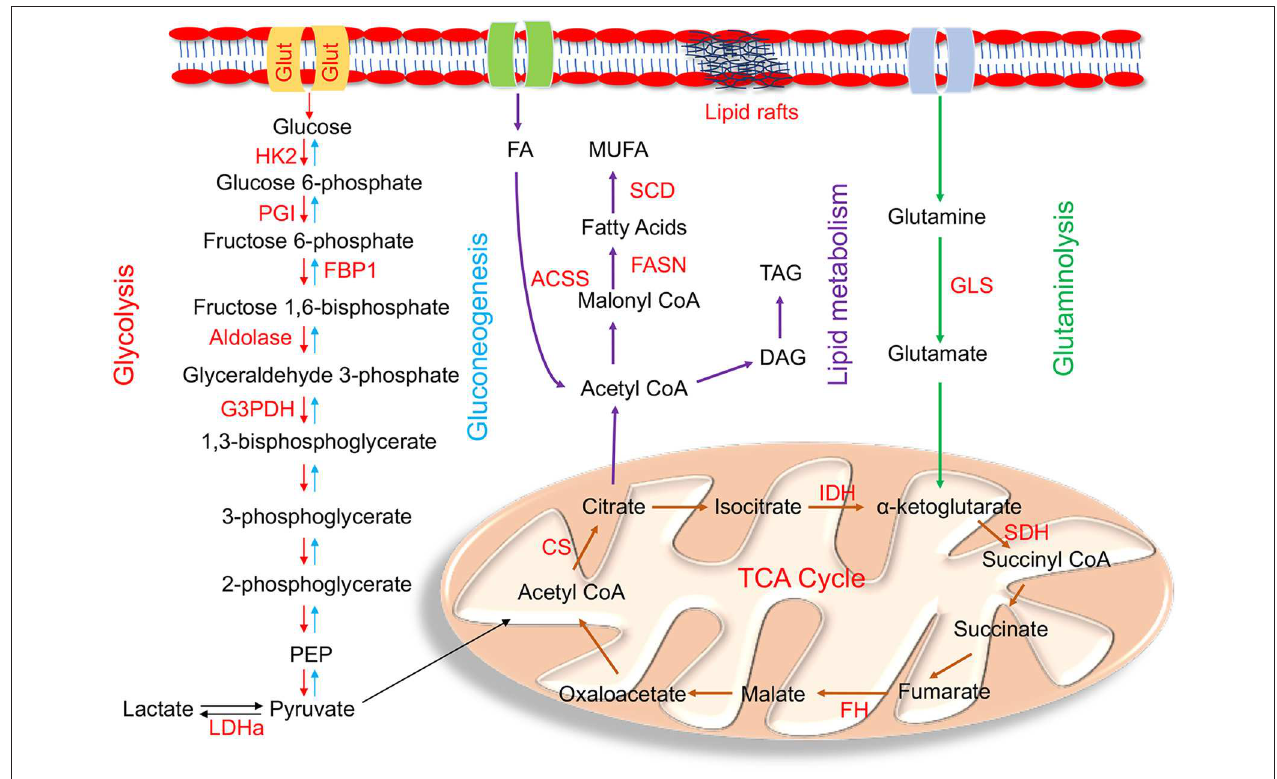
FIGURE 1 | Enzymes within their pathways that are implicated in metabolic reprogramming during EMT. Schematic diagram of enzymes (highlighted in red) within the metabolic pathways of glycolysis, gluconeogenesis, mitochondrial, glutamine, and lipid metabolism alluded in the text that are altered during metabolic reprogramming that occurs in EMT. The main glycolytic enzymes that are upregulated in EMT are HK2 (hexokinase 2); PGI (phosphoglucoisomerase); aldolase, G3PDH (glyceraldehyde-3-phosphate dehydrogenase), and LDHa (lactate dehydrogenase a). FBP1 (fructose-1,6-bisphosphatase), the rate limiting enzyme of gluconeogenesis, is downregulated during EMT. Mutations in the tri-carboxylic acid (TCA) cycle enzymes linked to EMT are IDH (isocitrate dehydrogenase); SDH (succinate dehydrogenase); FH (fumarate hydratase); and CS (citrate synthase). The key enzyme involved in glutaminolysis is GLS (Glutaminase). De novo lipogenesis key enzymes involved in lipid metabolism are ACSS (acyl CoA synthetase); FASN (fatty acid synthase); and SCD (stearoyl CoA desaturase). Cells undergoing EMT also have high TAG (Triacylglycerols)